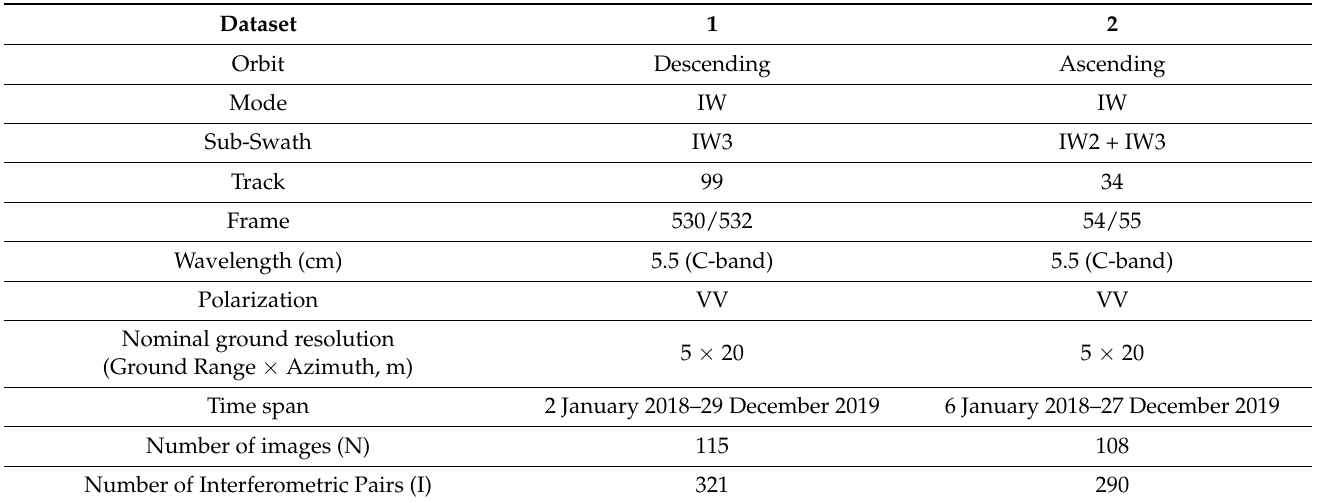
Table 1. Characteristics of the Sentinel-1 SLC data used in this study in DInSAR processing. The nominal spatial resolution is specified for single-look data. N is the number of used SAR images, and I is the number of interferograms for each dataset calculated and analyzed in this